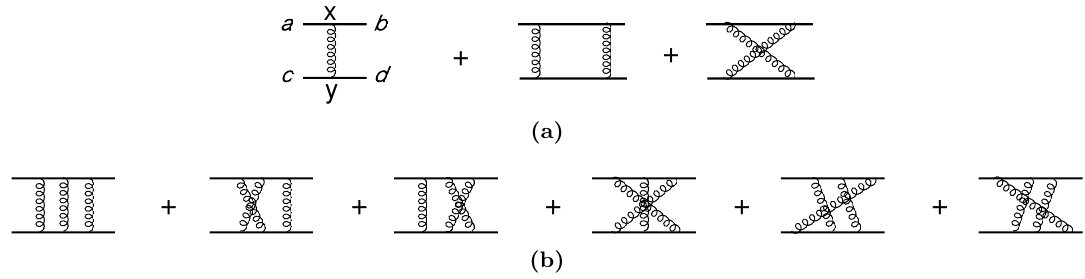
Figure 1. The one, two (a) and three (b) gluon exchange contributions to the algebra. where the relative order of the vertices on the target gluon line is permuted in all possible ways. These are the relevant diagrams for eikonal scattering in the Lorentz gauge. The ) contributions correspond to the three gluon exchange diagrams ((cid:12)gure 1-b). O ( (cid:11) 3 s With the algebra encoded in eq. (2.3) and the rule for calculating scattering